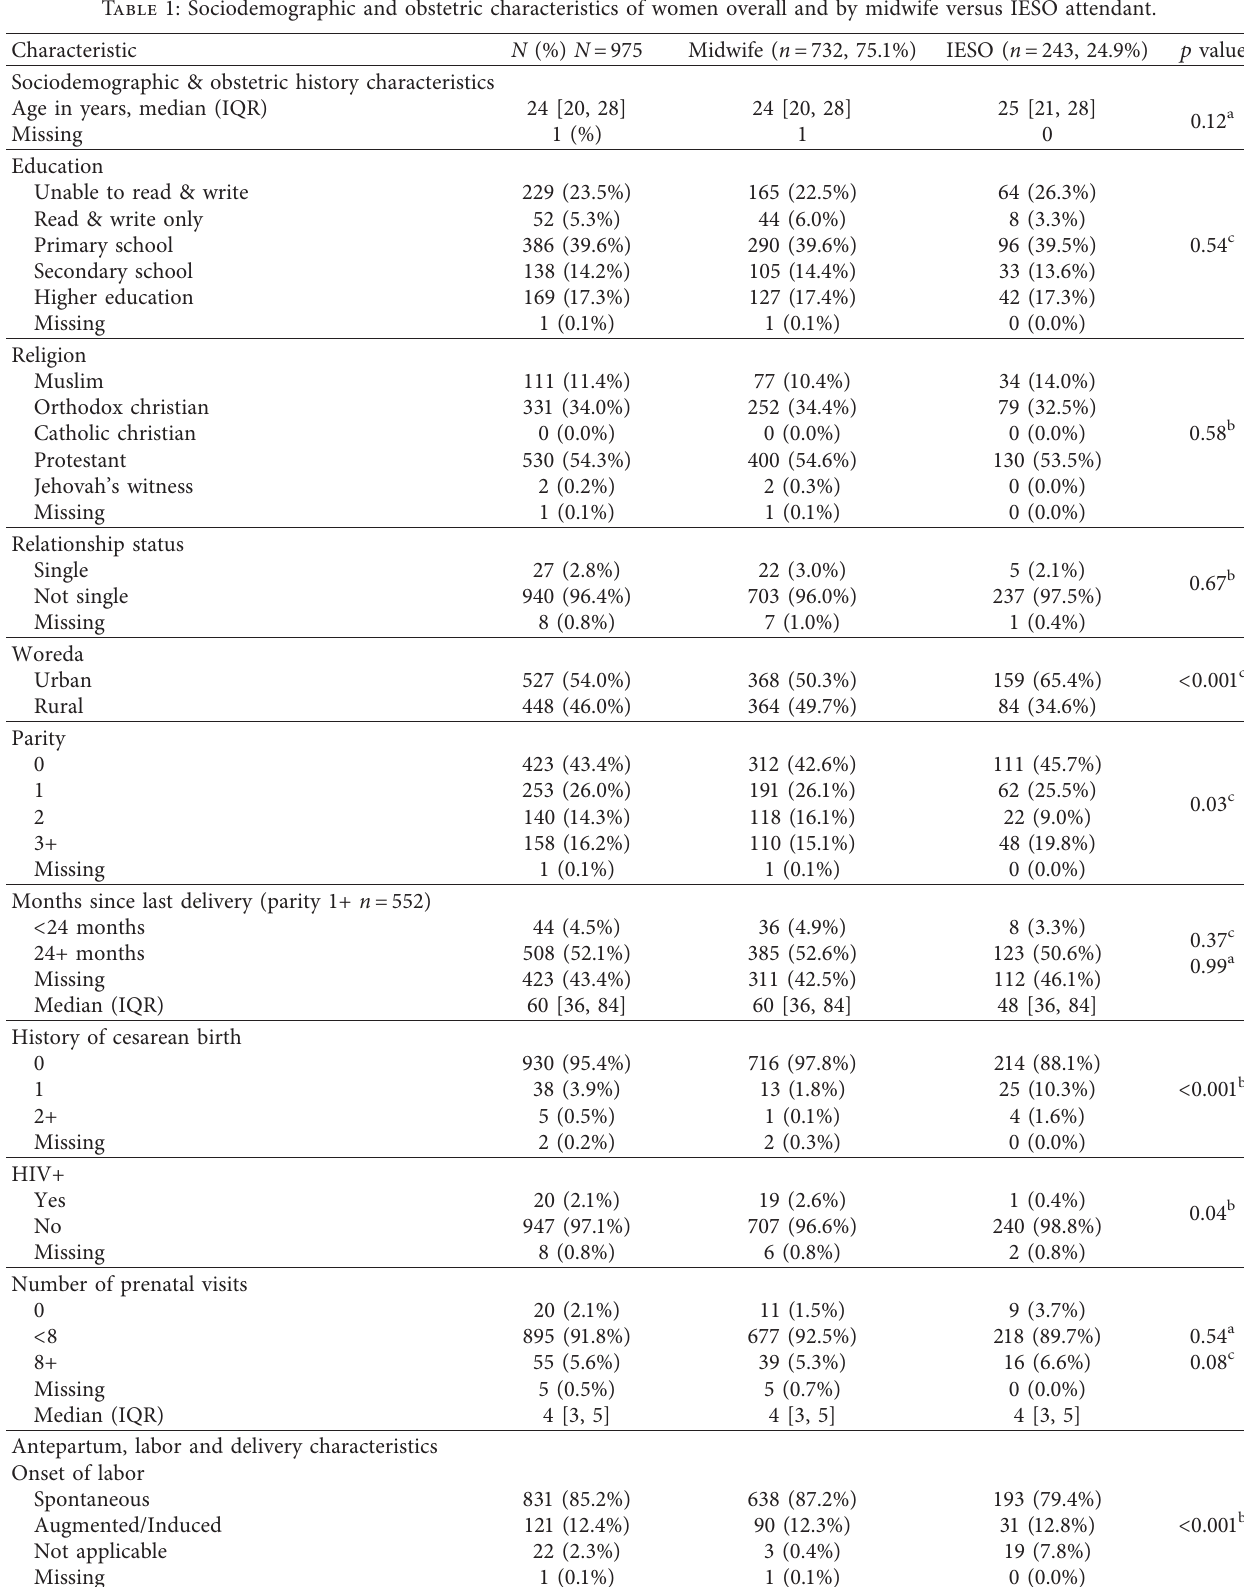
Table 1: Sociodemographic and obstetric characteristics of women overall and by midwife versus IESO attendant.